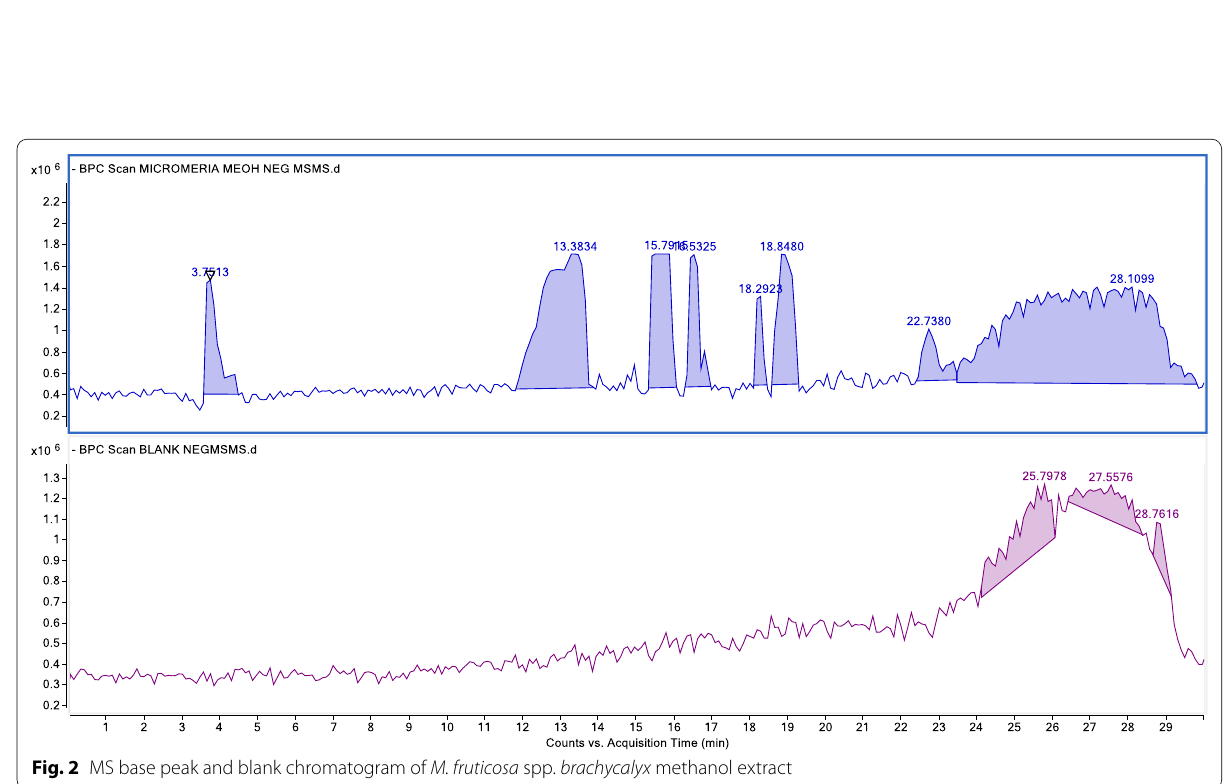
Fig. 1 MS base peak and blank chromatogram of R. coriaria methanol extract